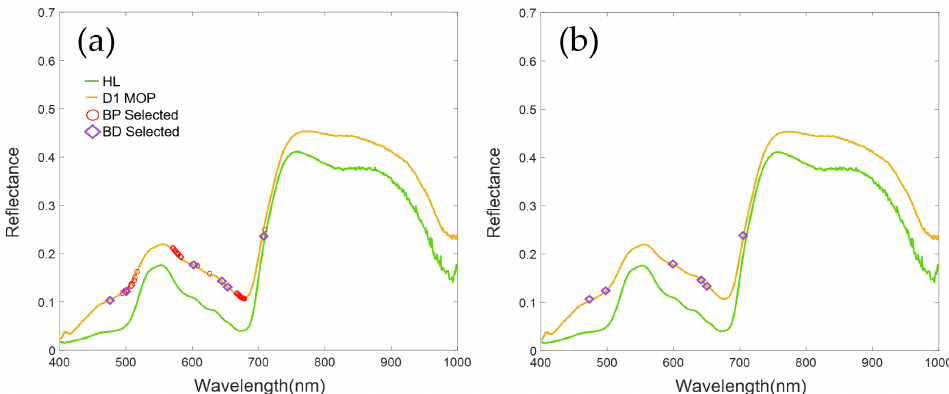
Figure 8. Bands selected through band prioritization ( a ) and band decorrelation ( b ) using criteria of entropy. Red circles denote bands selected from band prioritization, and purple diamonds denote bands selected after band decorrelation.